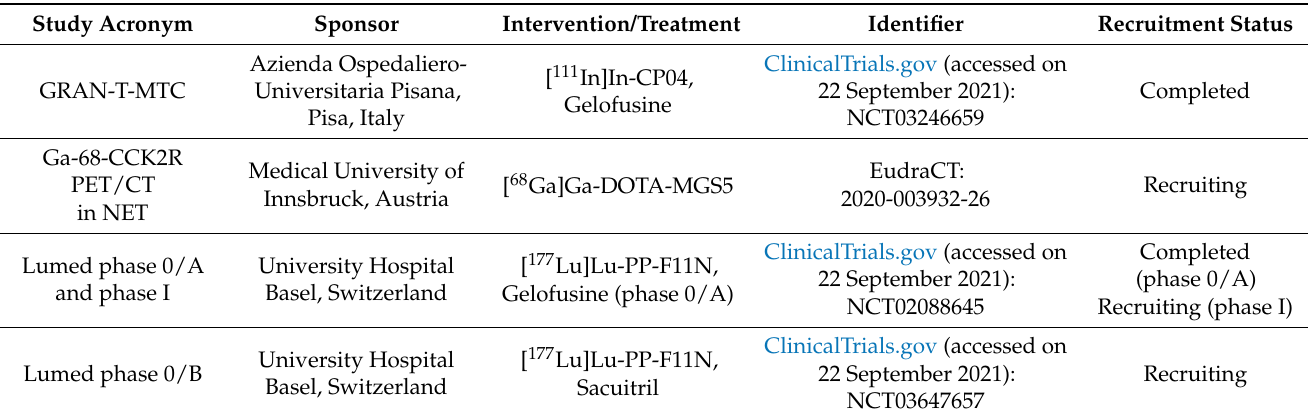
Table 4. Summary of recent clinical studies with radiolabeled CCK2R targeting peptide analogs. Study